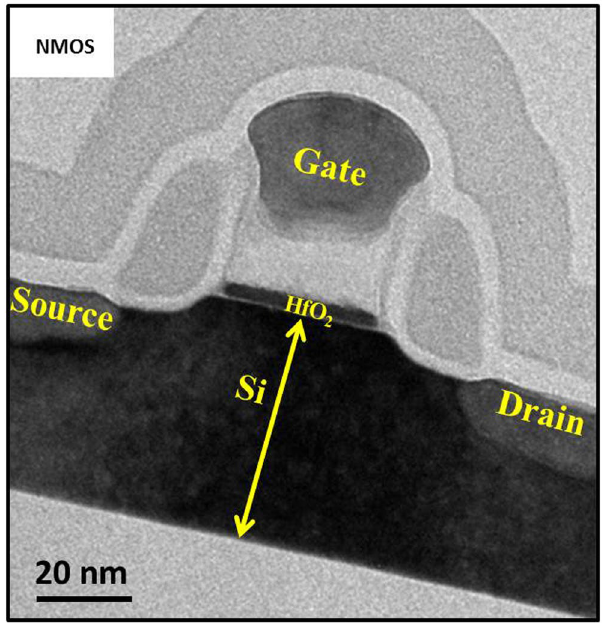
Figure 6. TEM image of the fabricated PD-SOI MOSFET at 32 nm technology node with 1.7 nm HfO 2 gate